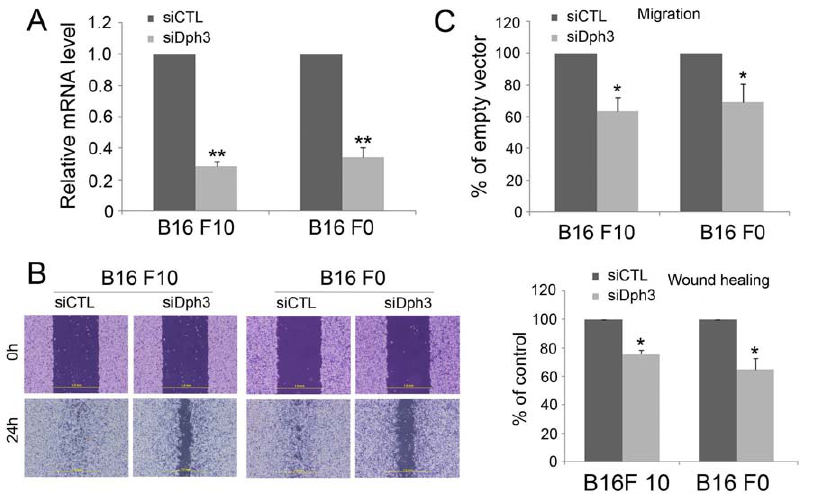
Figure 2. Dph3 silencing decreases the migration of melanoma B16F10 and B16F0 cells. A, pSilence4.1-CMV vectors carrying siDph3 or siCTL were transfected into melanoma B16F10 and B16F0 cells separately. mRNA expression level of Dph3 was determined by real-time PCR. B, both siDph3 and siCTL transfected cells were plated in 6 cm dishes. A wound healing assay was performed to determine the metastatic potential of cells and representative pictures of the wound distance were taken at 0 and 24 h post scratching as indicated (left). The percentage of wound closure was quantified (right). C, the cell motility was evaluated by transwell assays. Data are from three repeated experiments and are average 6 S.E. values. *p , 0.05, ** p , 0.01, compared to control cells.